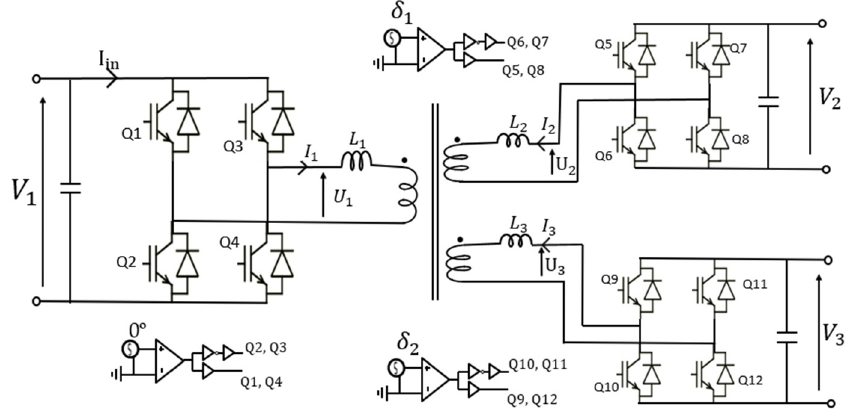
Figure 2. Schematic for the simulated TAB converter under the SPS control scheme.